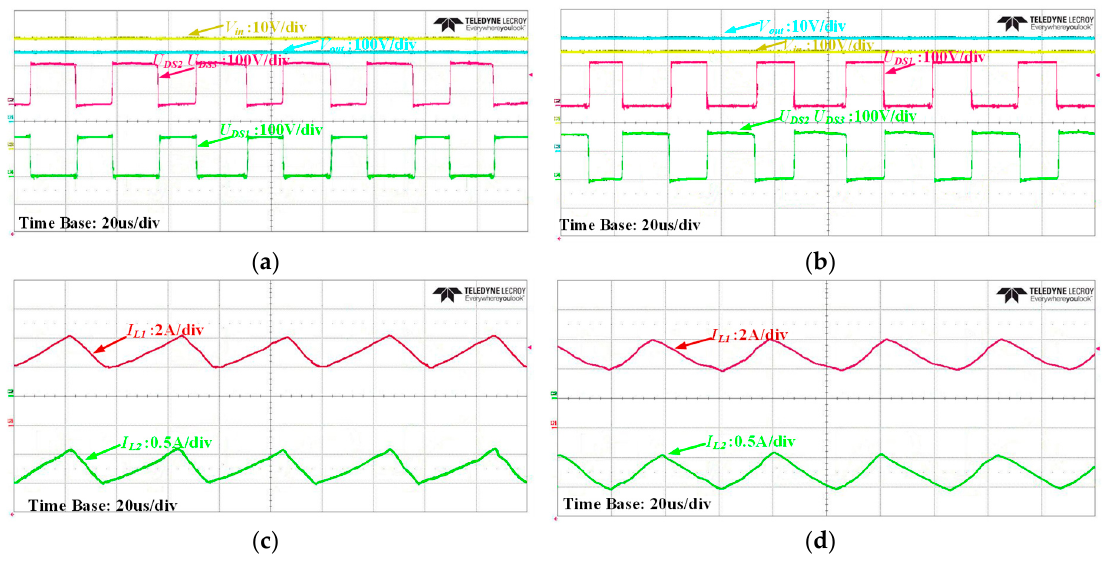
Figure 16. Experimental results: ( a ) voltage stress across Q 1 –Q 3 in boost mode, ( b ) voltage stress across Q 1 –Q 3 in buck mode, ( c ) inductor current in boost mode, and ( d ) inductor current in buck mode.